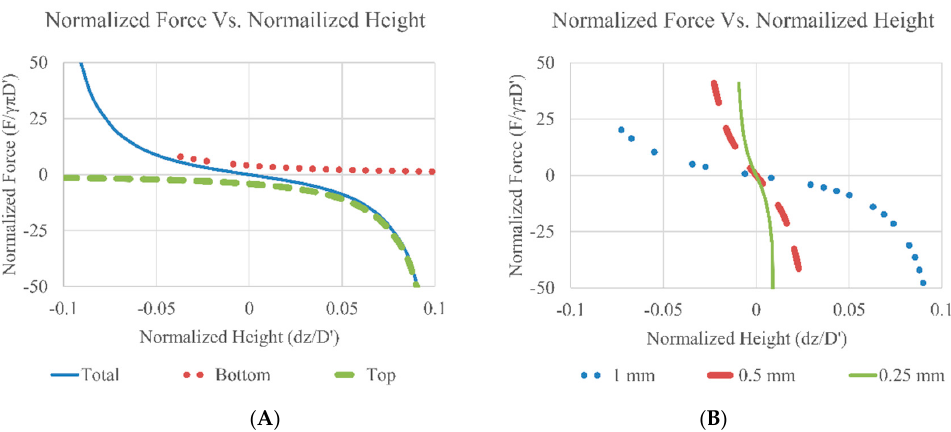
Figure 10. Opposing droplet configuration. Two identical droplets are used to provide support on either side of the center plate. Both the top and bottom plates are fixed. The resulting force and stiffness is symmetrical around the midpoint ( z = 0). The left and right illustrations shows the droplet shape when the center plate is displaced around the balance point.